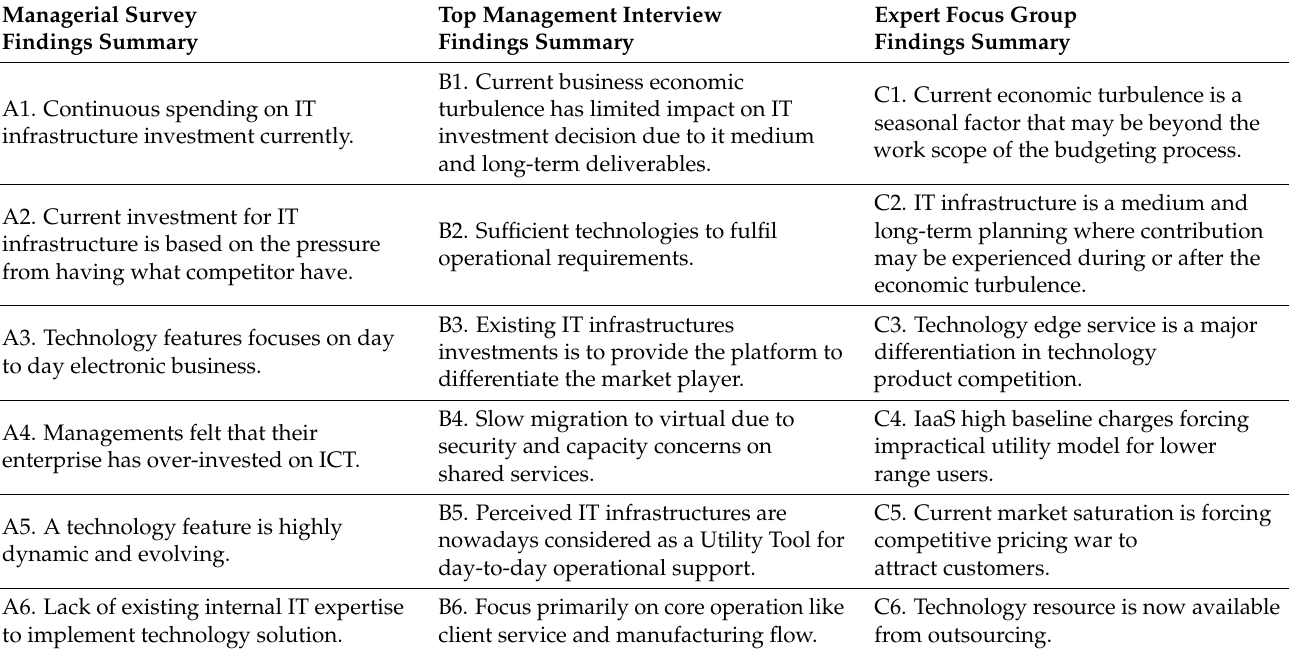
Table 6. Finding Data Analysis